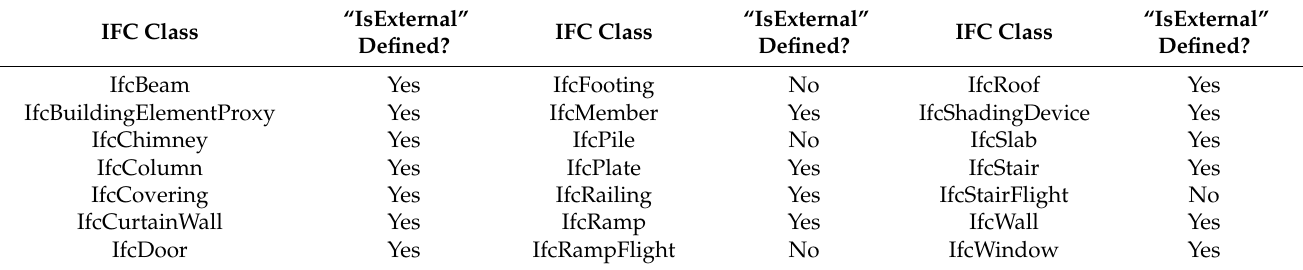
Table 3. Industry Foundation Classes (IFC) building elements with the “IsExternal”